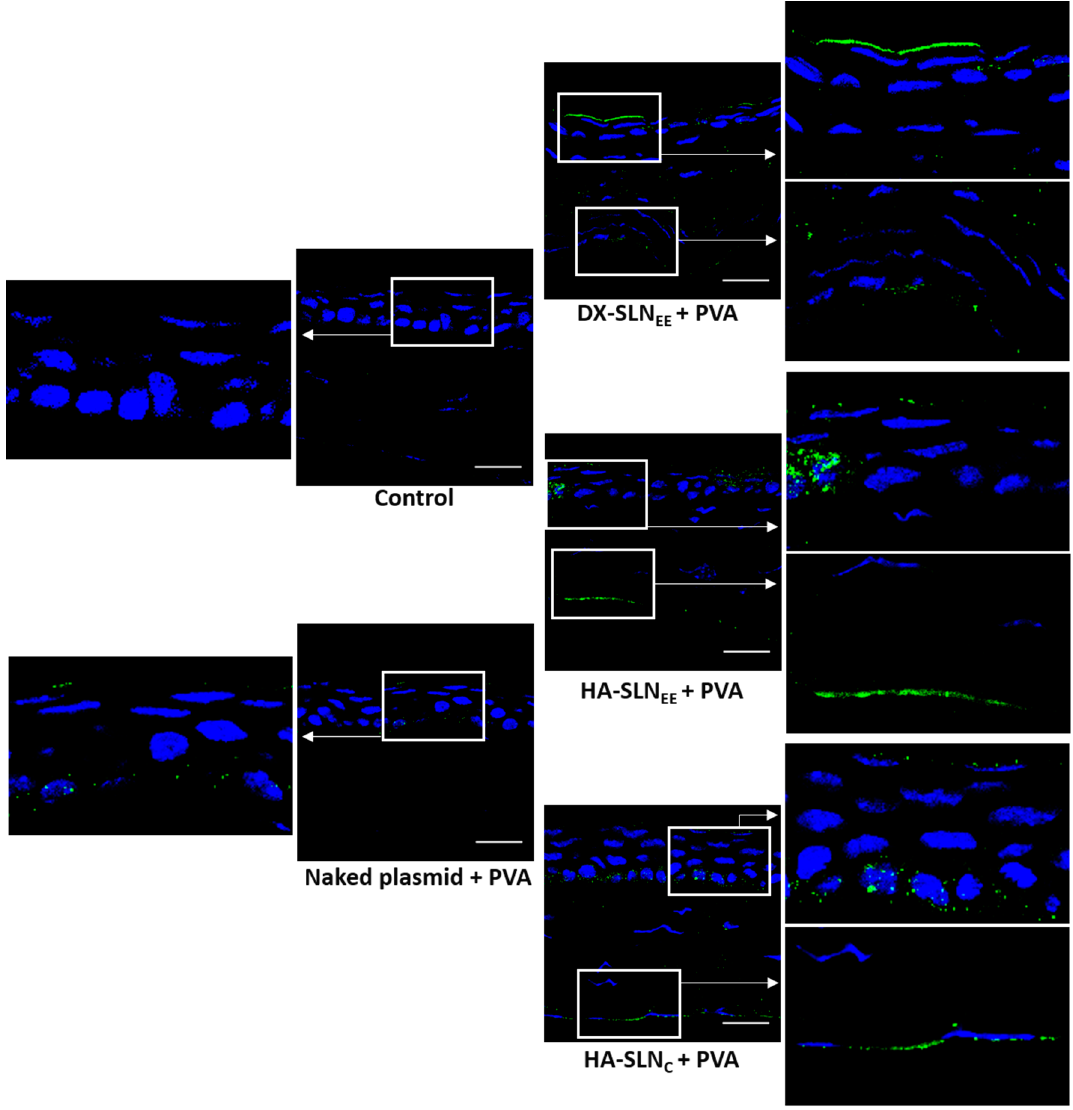
Figure 8. Corneal transfection in vivo in IL-10 KO mice treated with naked plasmid and vectors bearing the plasmid pUNO1-hIL10 with PVA (60 × ). Blue: nuclei stained with DAPI. Green: IL-10. Scale bar: 20 µ m. For each sample, a global image of the corresponding corneal section and a magnification of the epithelium and endothelium areas have been included. Arrows in magnifications indicate detection of IL-10. DX: dextran; SLN: solid lipid nanoparticle; PVA: polyvinyl alcohol; HA: hyaluronic acid.